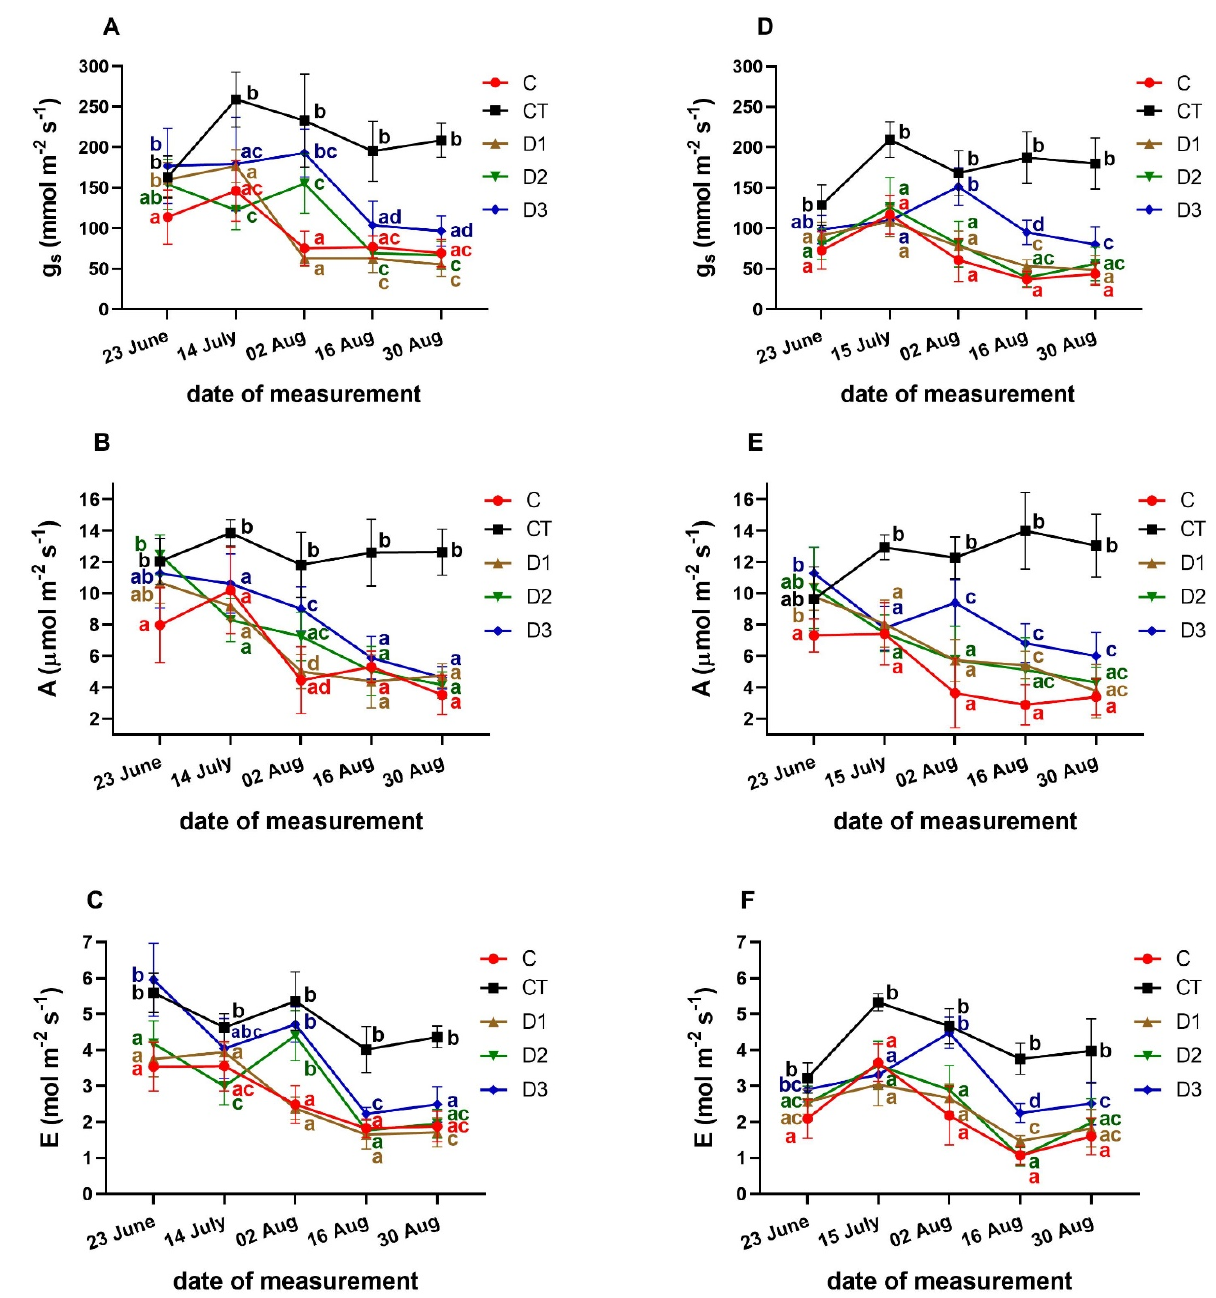
Figure 3. ( A − F ) Effects of treatments on gas exchange parameters on Chardonnay ( A − C ) and Kékfrankos ( D − F ) varieties in 2013: g s (mmol m − 2 s − 1 ) − stomatal conductance ( A , D ), A (µmol CO 2 m − 2 s − 1 ) − assimilation rate ( B , E ), and E (mol H 2 O m − 2 s − 1 ) − transpiration rate ( C , F ) during the growing seasons. Each symbol represents the mean value ± standard deviation (SD). Significance groups of each measurement date are marked with letters ( p < 0.05). The color of the letters corresponds to the color of the treatments.